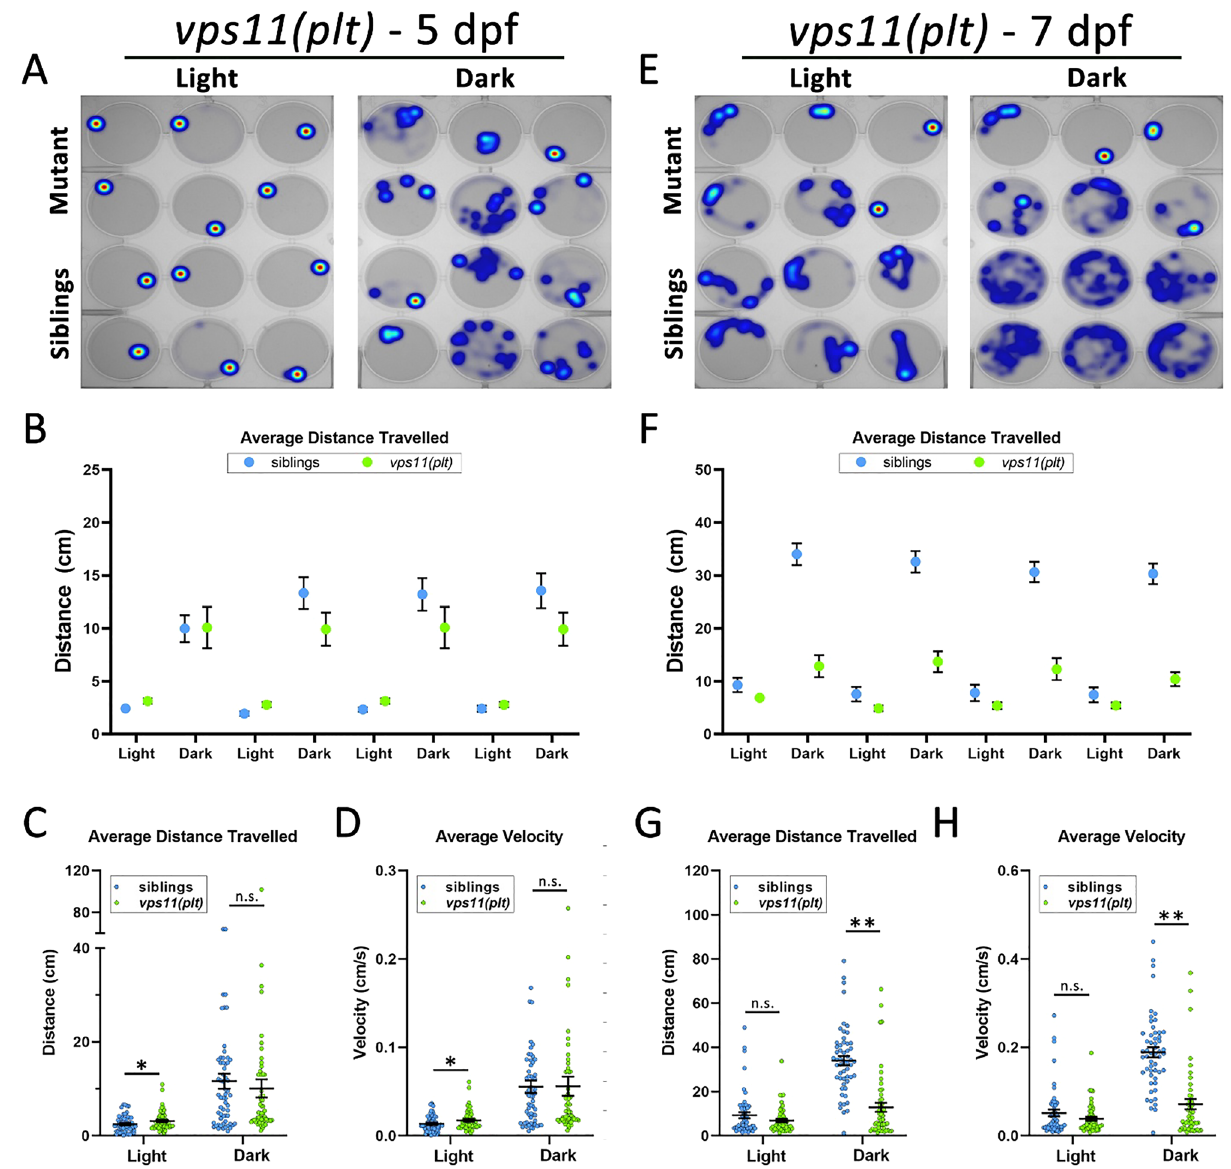
Figure 2. vps11(plt) mutants show normal distance travelled and velocity at 5dpf and significantly reduced distance travelled and velocity at 7dpf during alternating cycles of light and dark. ( A ) Representative heat maps of total distance moved by individual larvae at 5dpf ( vps11(plt) mutants = top two rows; siblings = bottom two rows) during a 3-min period of light and dark. ( B ) Graph representing average distance travelled in 4 alternating light–dark cycles of 3 min each (sibling larvae in blue; vps11(plt) mutants in green). ( C ) Graph representing average distance travelled in light and dark periods. ( D ) Graph representing average velocity of sibling larvae and vps11(plt) in light and dark periods. n = 60 sibling and 60 vps11(plt) larvae at 5 dpf. ( E ) Representative heat maps displaying total distance moved by individual larvae at 7dpf ( vps11(plt) mutants = top two rows; siblings = bottom two rows) during a 3-min period of light and dark. ( F ) Graph representing average distance travelled by larvae in 4 alternating light–dark cycles of 3 min each (sibling larvae in blue; vps11(plt) mutants in green). ( G ) Graph representing average distance travelled in light and dark periods. ( H ) Graph representing average velocity of sibling larvae and vps11(plt) in light and dark periods. n = 54 sibling and 52 vps11(plt) larvae. * P < 0.05, ** P < 0.01. Error bars indicate